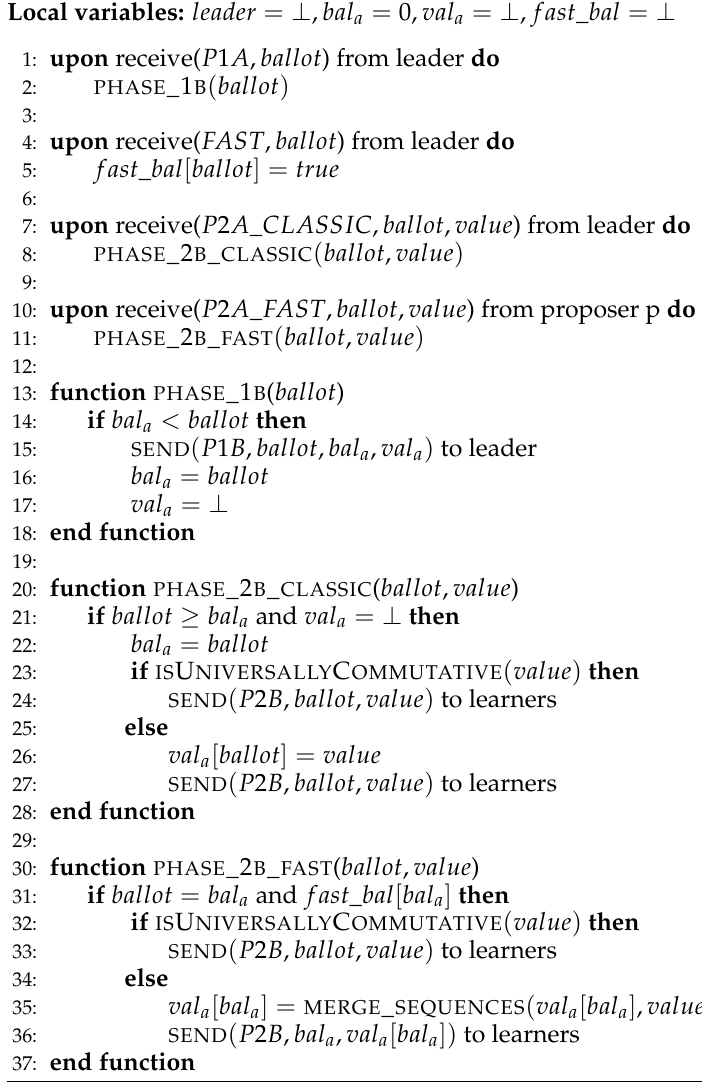
Algorithm 4 Generalized Paxos—Acceptor